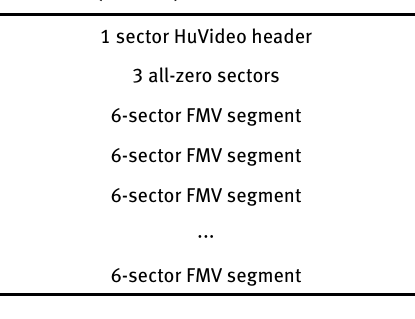
Table 4. GB (HuVideo) FMV format.